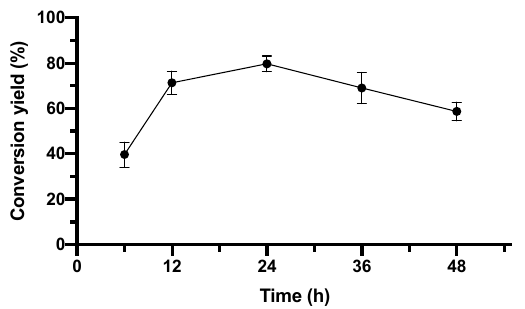
Figure 5. Effect of different reaction times of conversion yield of UDCA-monoglyceride. All quantifi- cations were performed in triplicate.